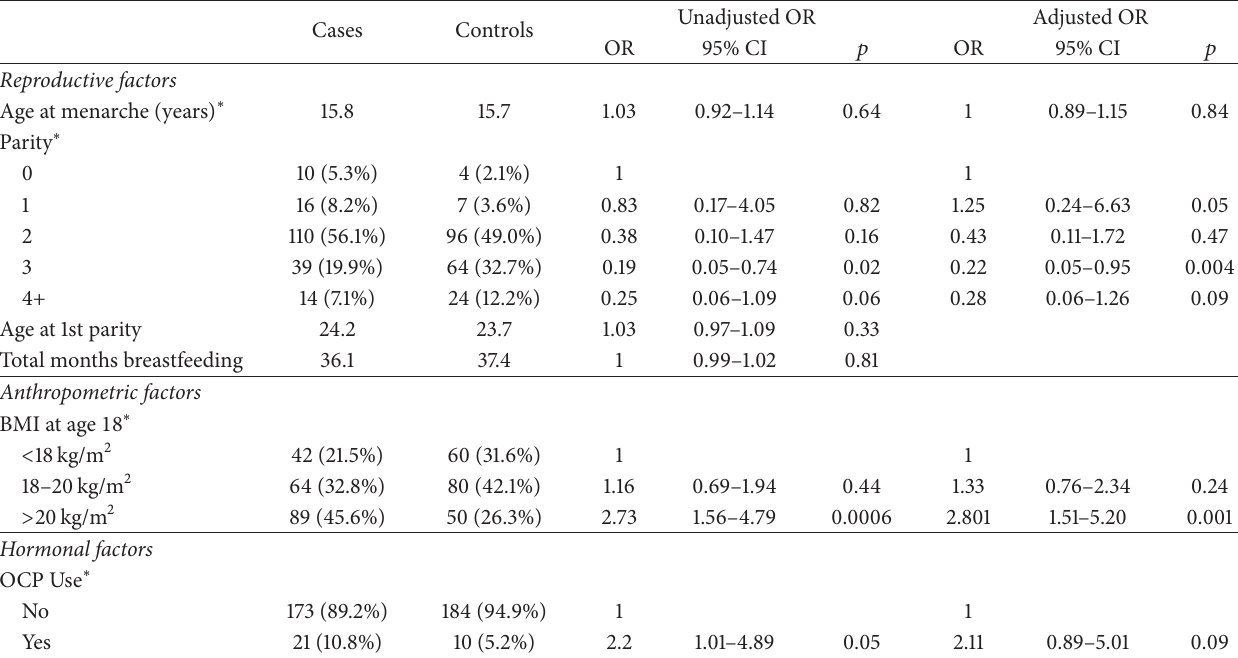
Table 5: Conditional logistic regression analysis to estimate the odds (odd ratio, OR) of breast cancer in premenopausal women. Cases